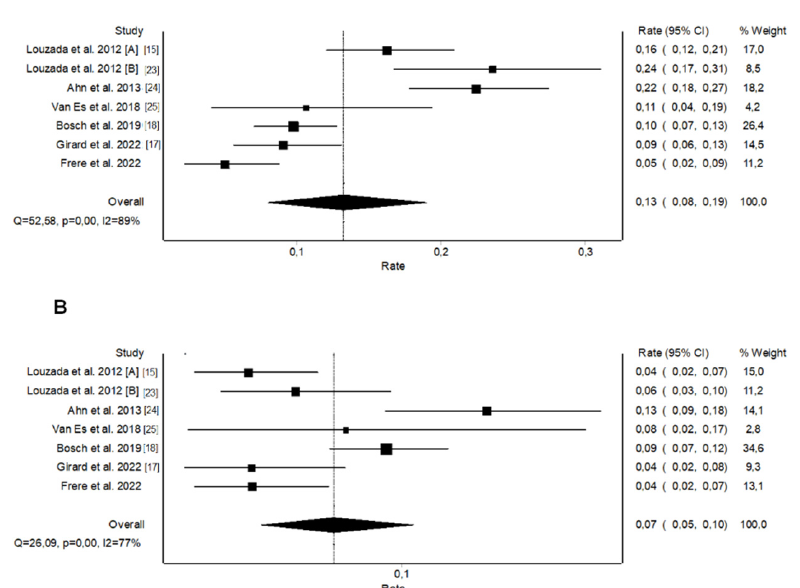
Figure 3. Pooled rates of recurrent venous thromboembolism for the original Ottawa score: ( A ) High ‐ risk patients, ( B ) Low ‐ risk patients.